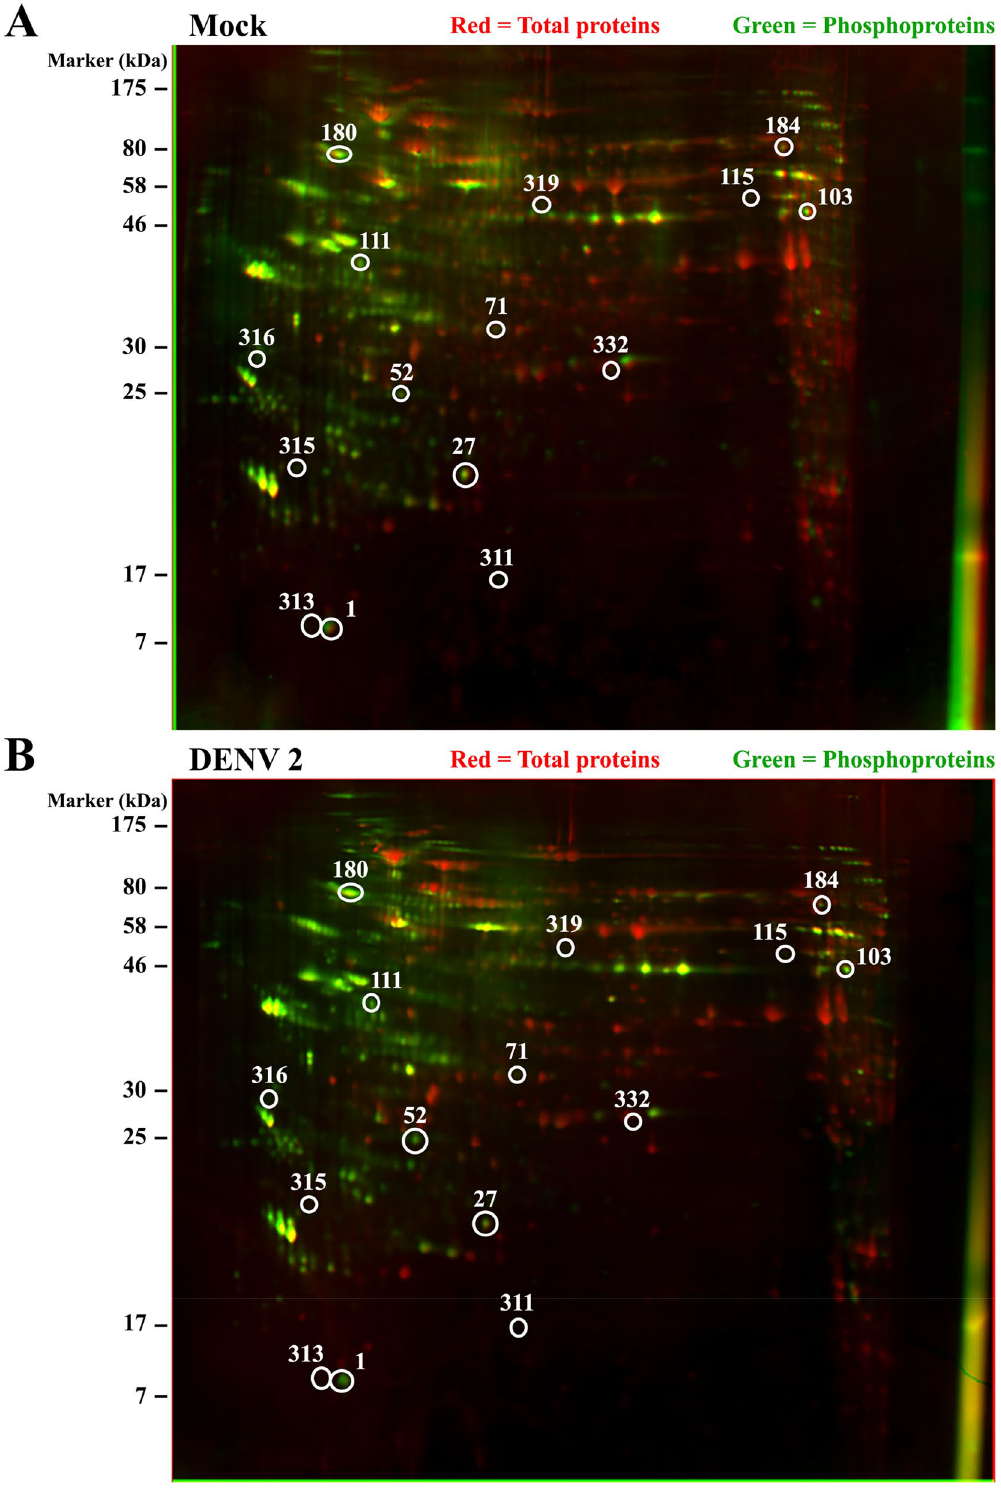
Figure 1. 2-DE gels of purified phosphoproteins from U937 Mock and DENV 2 infected cells. Dual view of gels stained with ProQ Diamond (Green) and subsequently with SYPRO Ruby (red) to detect specifically phosphoproteins and total proteins, respectively. Mass spectrometry identified phosphoproteins are labelled by numbers corresponding to their identification demonstrated in Table 1 ( A ) Dual view of ProQ Diamond and SYPRO Ruby staining of Mock protein extracts after phosphoprotein enrichment. ( B ) Dual view of ProQ Diamond and SYPRO Ruby staining of DENV 2 protein extracts after phosphoprotein